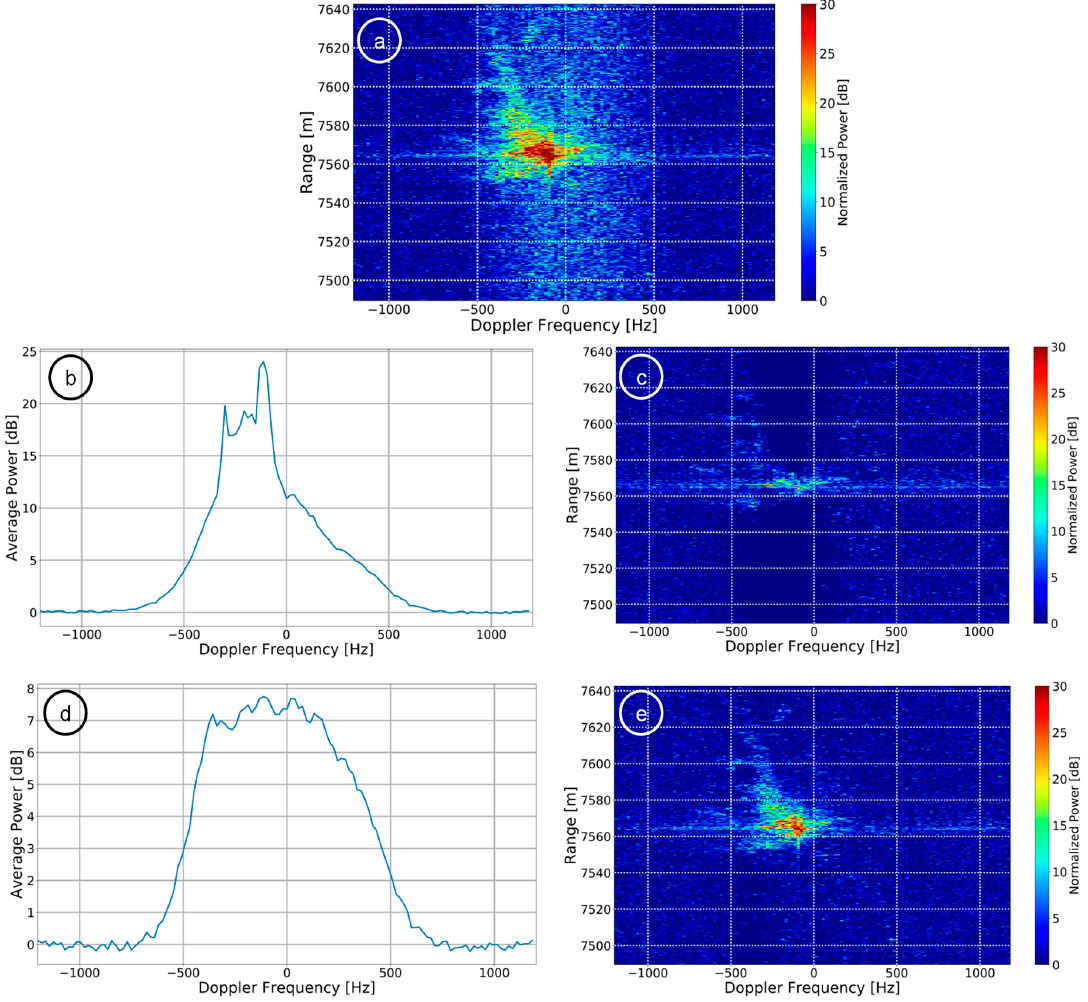
Figure 16. Data containing a ship target: ( a ) range-Doppler image before clutter normalization, ( b ) average Doppler spectrum estimated without using pre-detection for removing the target from ( a ), ( c ) normalized image after using the average Doppler spectrum from ( b ), ( d ) target free estimation of average power spectrum after using pre-detection algorithm, ( e ) normalized image after using ( d ).